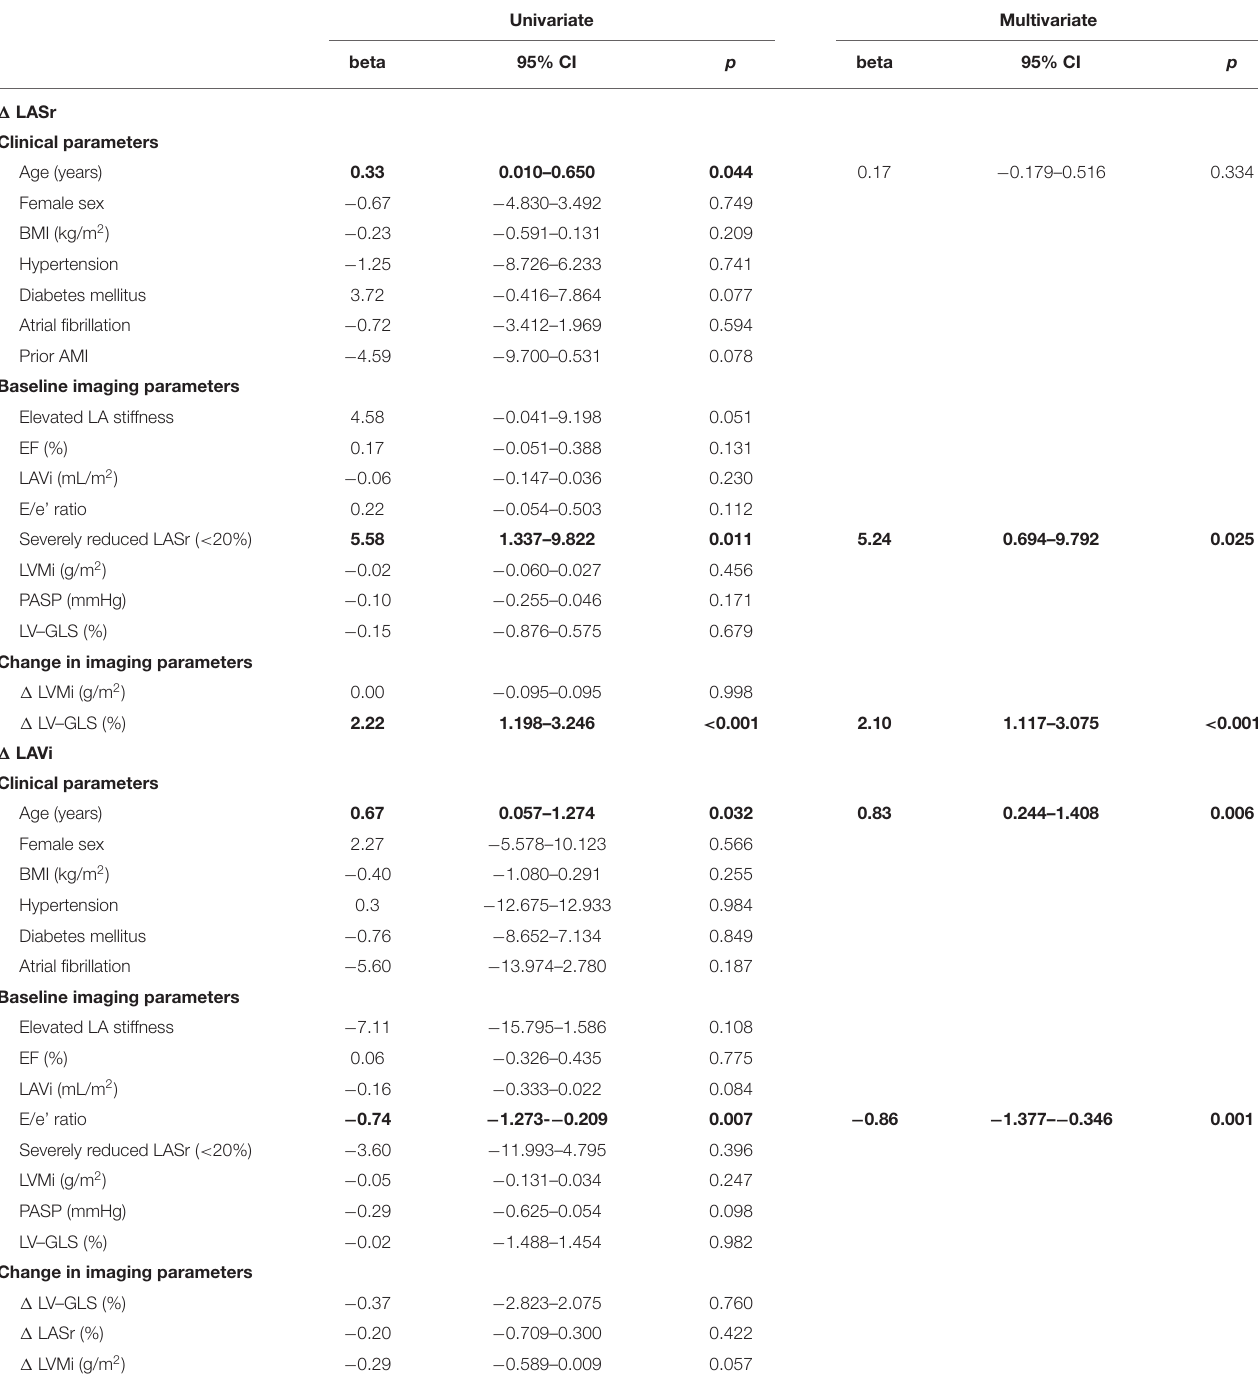
TABLE 3 | Uni- and multivariate linear regression analysis of the association of comorbidities, echocardiographic parameters and LA reverse